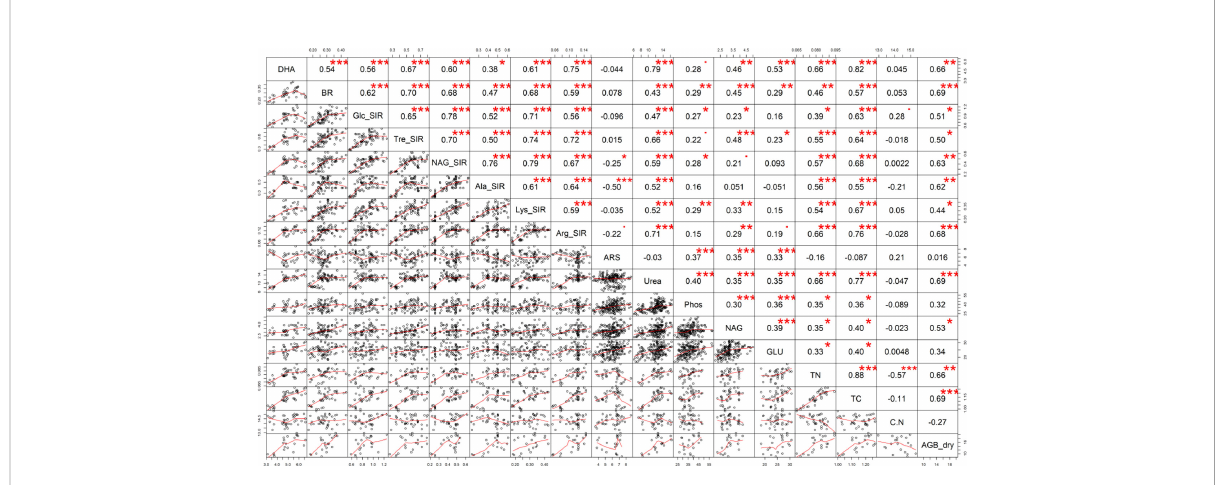
FIGURE 7 The Pearson ’ s correlation matrix of the soil properties. Explanation: Signi fi cance at · p ≤ 0.10; *p ≤ 0.05; **p ≤ 0.01; ***p ≤